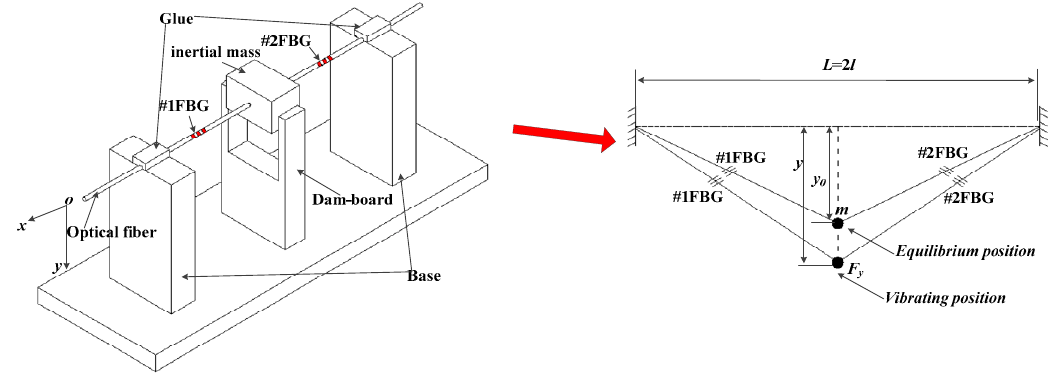
Figure 4. Schematic diagram of the FBG based micro-vibration sensor.